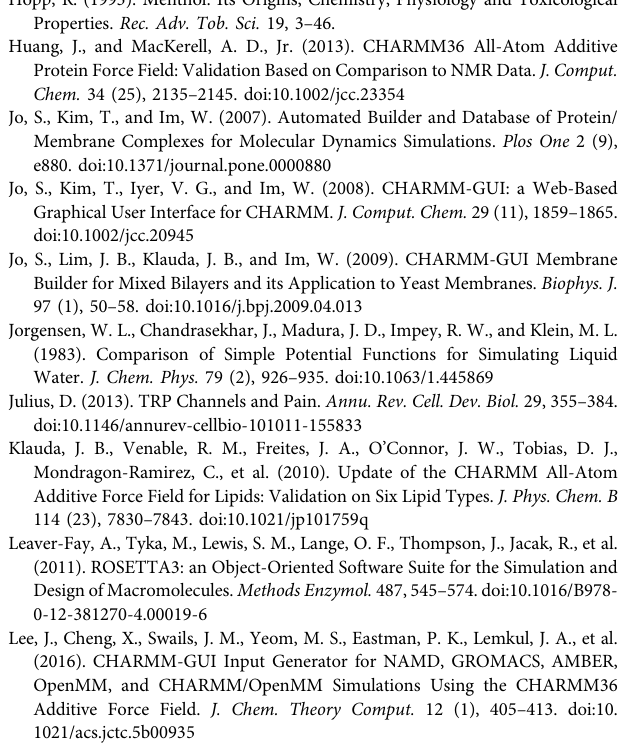
Supplementary Figure S1 | Binding energy contribution from menthol stereoisomers docking results. (A) Alignment of the amino acid sequence of S1 – S4 in murine TRPM8 (mTRPM8) and human TRPM8 (hTRPM8). The S1 to S4 regions (wave line in blue) are indicated. The protein sequence between mTRPM8 and hTRPM8 is highly conserved with the identity of 96.61%. (B) Representative whole-cell recordings showed that ( − )-menthol activated mTRPM8 at ± 80 mV. (C – G) Menthol stereoisomers docking models exhibited a funnel-shaped distribution of binding energy versus the ligand RMSD as calculated byRosetta(R.E.U.,Rosettaenergyunit).Thetoponemodelswiththelowestbinding energy, which was the docking model presented in Figure 4 , were highlighted in red. (H – L) Docking models with the best binding scores are clustered in a converged con fi guration. The cluster of representative ( − )-menthol, (+)-menthol, (+)-isomenthol, (+)-neoisomenthol, and (+)-neomenthol contained 9, 3, 6, 4, and 6 models among the top ten models, respectively. Supplementary Figure S2 | Molecular dynamic analysis of TRPM8 and menthol ligand. (A) RMSD of S1 – S4 domains calculated by molecular dynamic stimulation during 378 ns is around 3 Å. (B) Ensemble plot of ( – )-menthol molecule during stimulation. The con fi guration from the beginning is shown in red, and the con fi guration at the end is shown in blue. (C) Distance between speci fi c atoms of ( – )-menthol and residues is displayed. The distance between the oxygen atom in menthol and the OD atom of D802 is shown in blue line, and the distance between the C9 atom in menthol and CD atom of I846 is shown in gray